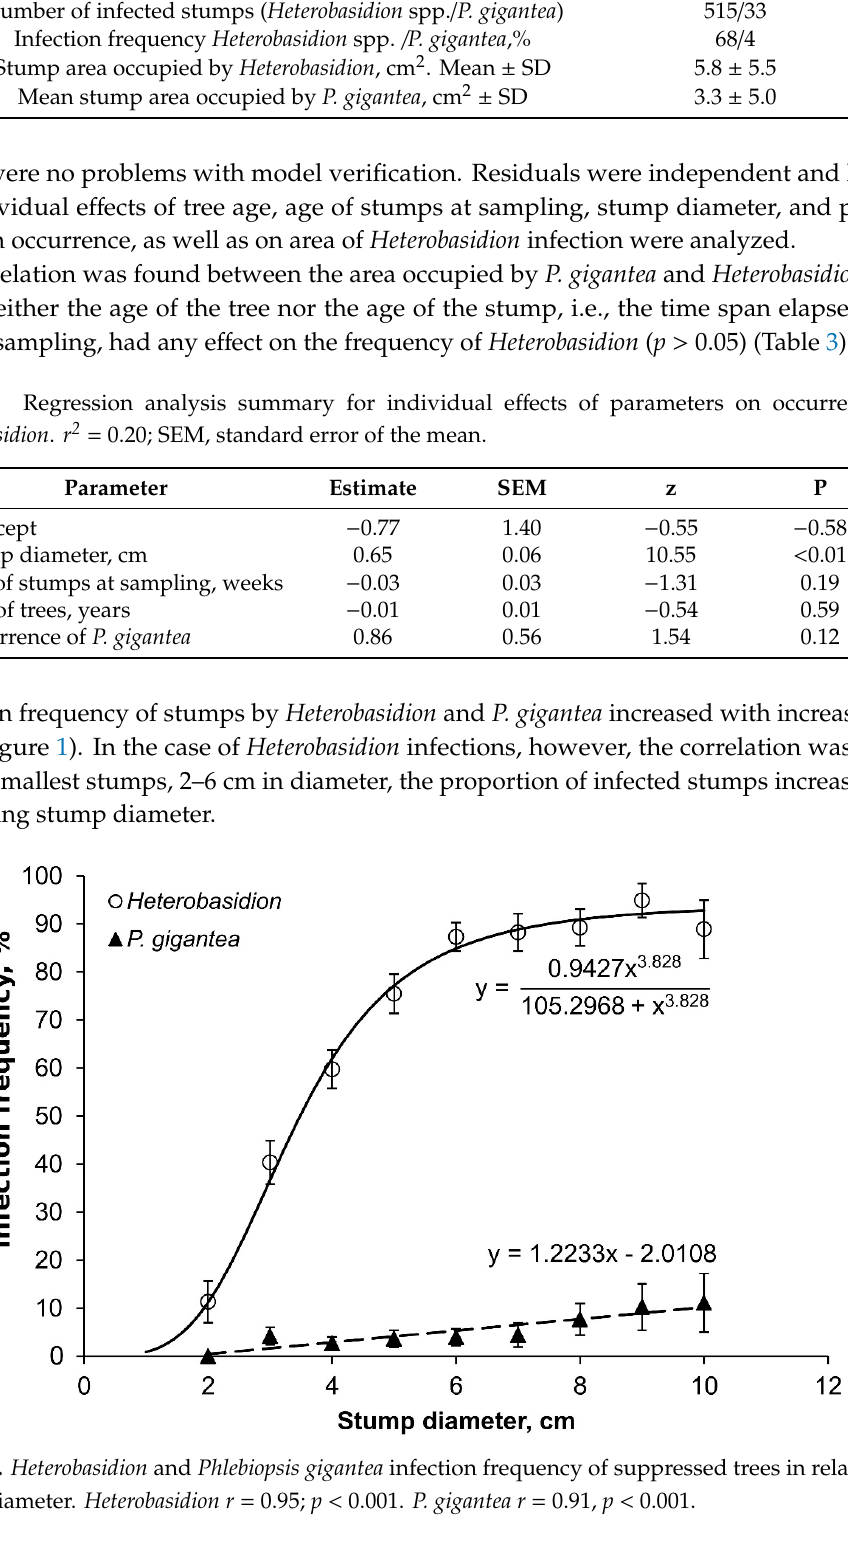
Table 2. Characteristics of sampled understory Norway spruce stumps and average infection frequency of Heterobasidion spp. and Phlebiopsis gigantea.